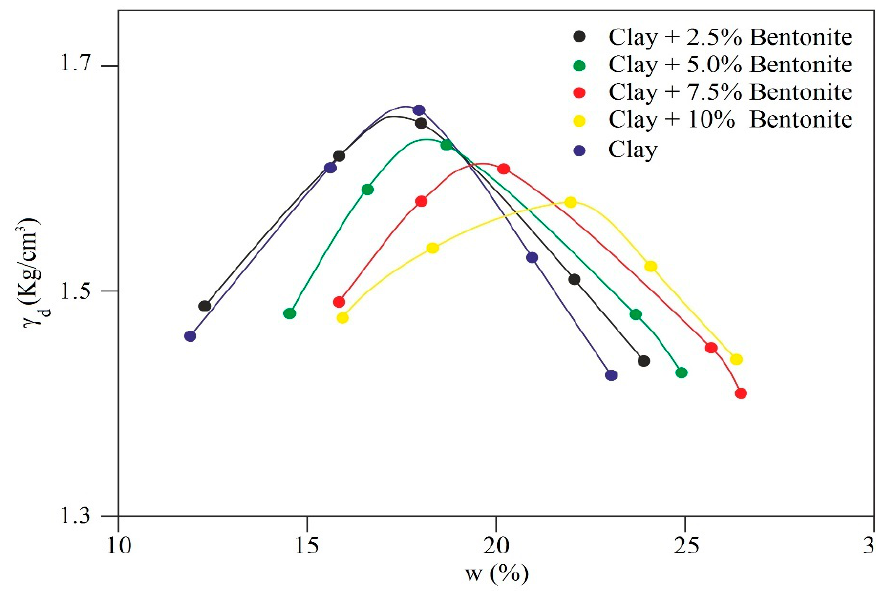
Figure 3. Effect of the Bentonite additive on the compaction behavior in clayey soil.